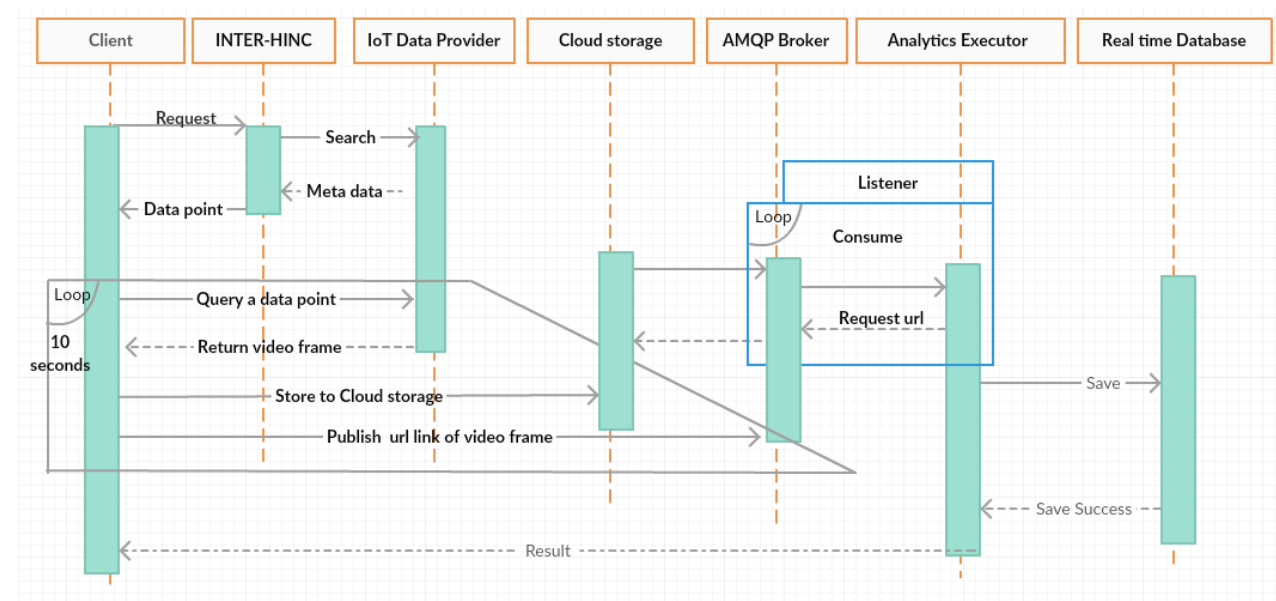
Figure 6. Haivan Sequence Project